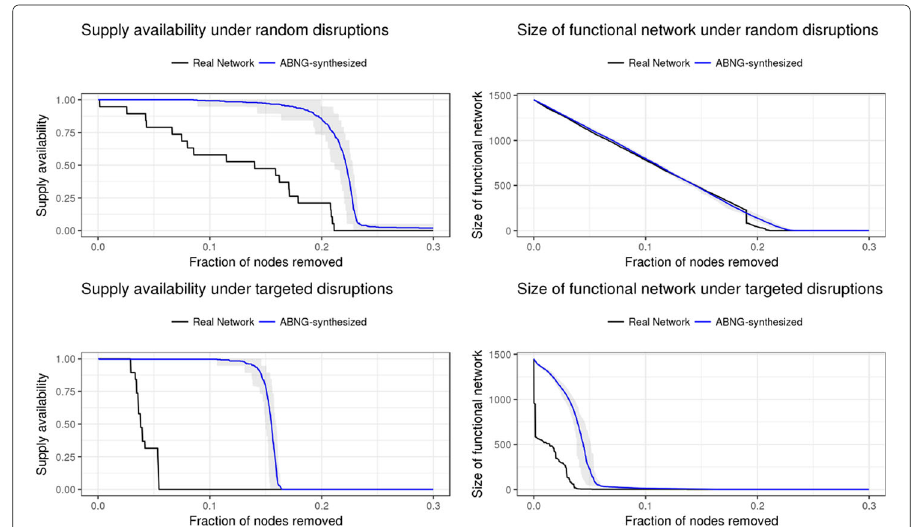
Fig. 9 Supply network of Farm Machinery and Equipment